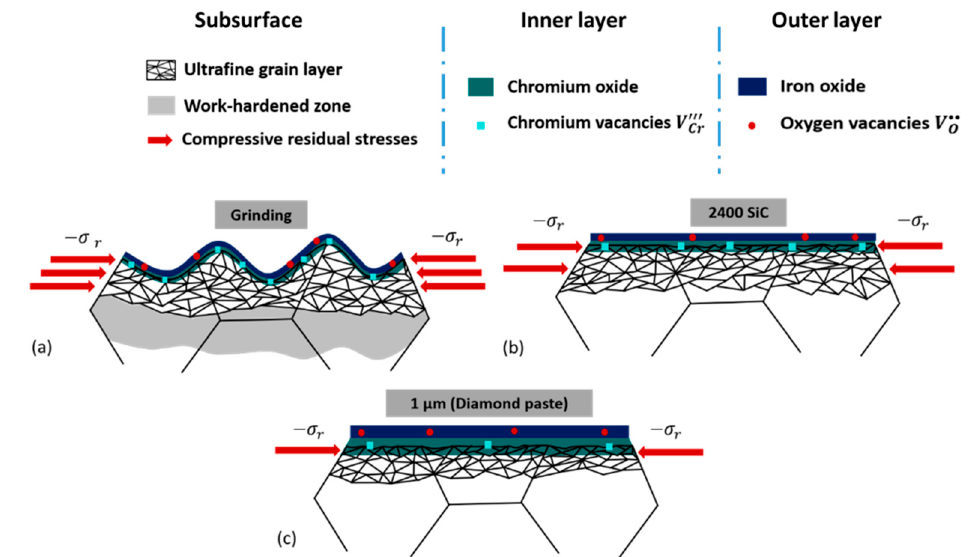
Figure 6. Diagram of passive film formed on surfaces after mechanical surface treatment on 304L specimens, ( a ) grinding process, ( b ) polished samples down to 2400 with SiC, ( c ) polished samples down to 1 µm with diamond paste.